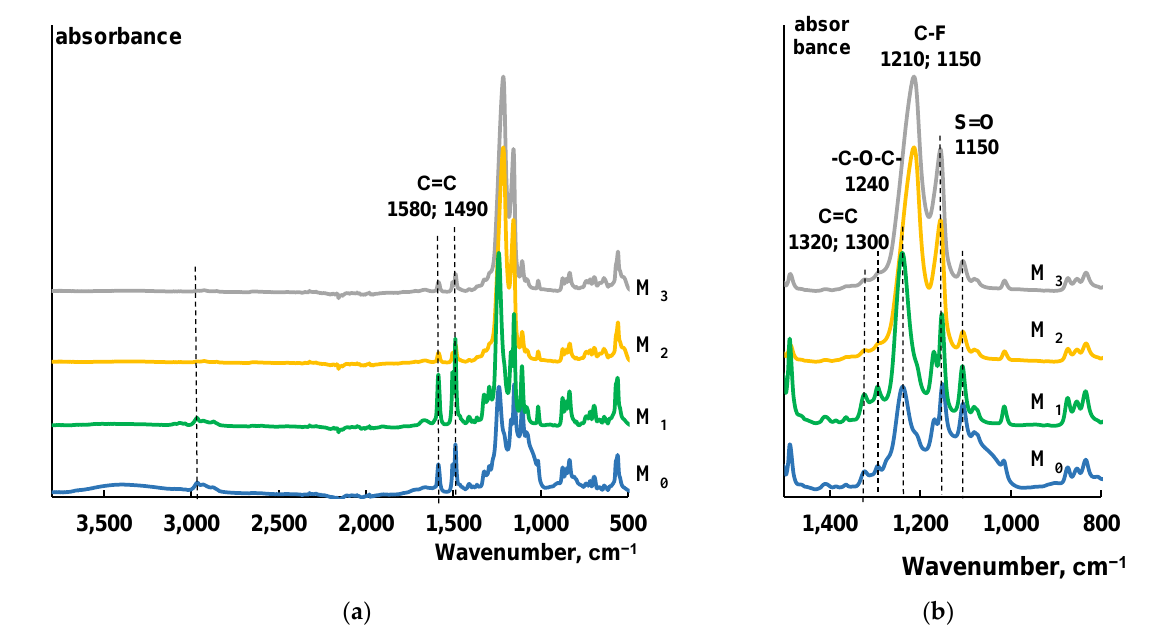
Figure 3. FTIR spectra ( a ) and fragment of FTIR spectra ( b ) of initial PSf-membrane and membranes modified with PTFE.